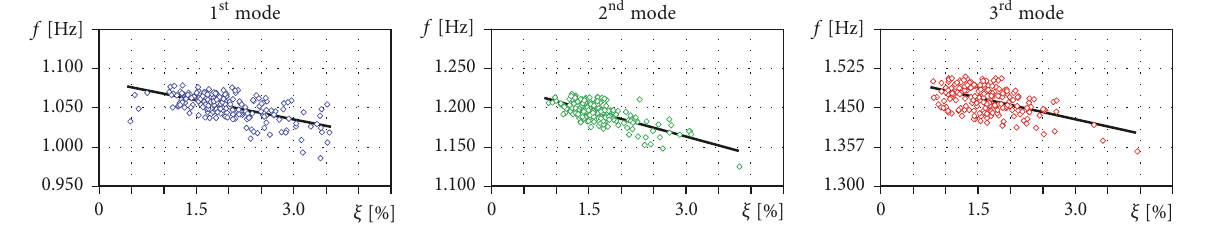
Figure 13: Correlation between frequencies and damping